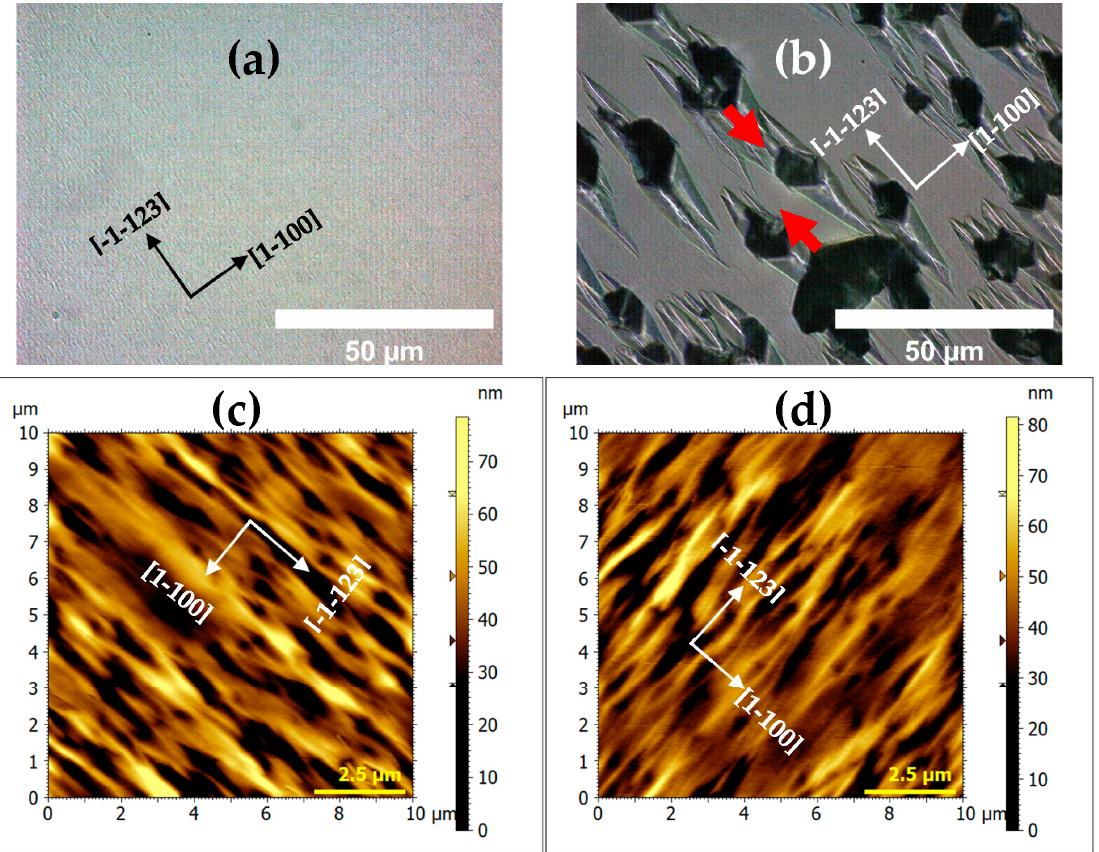
Figure 2. Optical microscope (OM) under 100× magnification and 5 × 5 µm AFM images for LED sample ( a , c ) LED A and ( b , d ) LED B. The red arrows indicated the mixed phase orientation twinning of (10–13) GaN where the growth directions formed 180°.